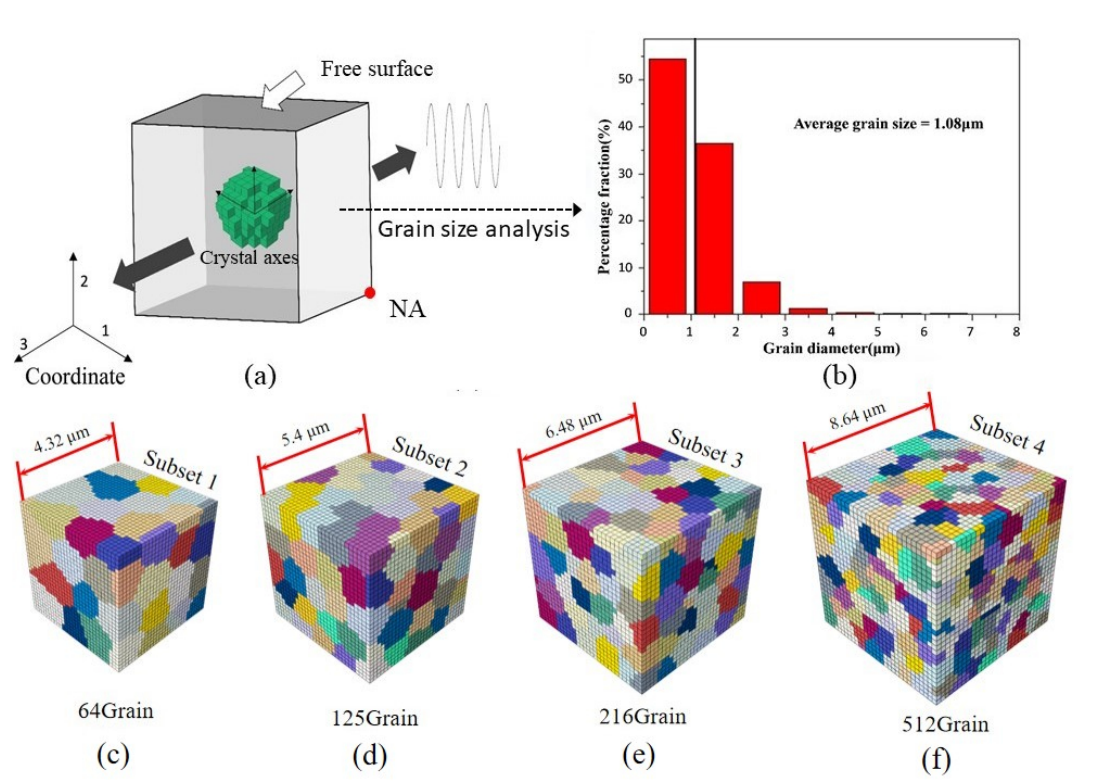
Figure 4. ( a ) Boundary condition and loading direction applied to RVE; ( b ) grain size analysis; ( c ) subset 1–64 grains; ( d ) subset 2–125 grains; ( e ) subset 3–216 grains; ( f ) subset 4–512 grains.